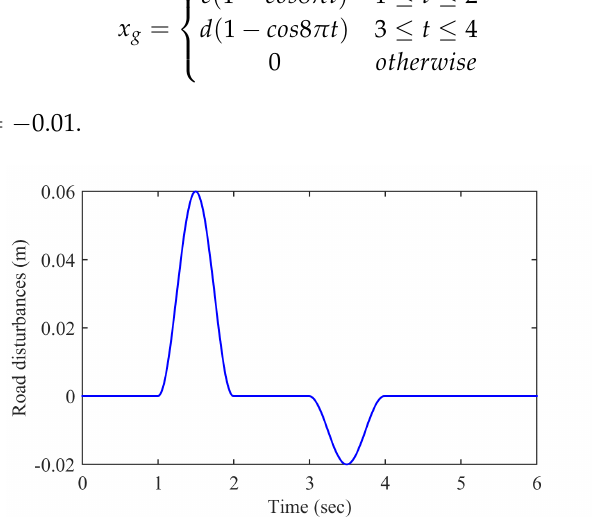
Figure 6. Road Disturbances.